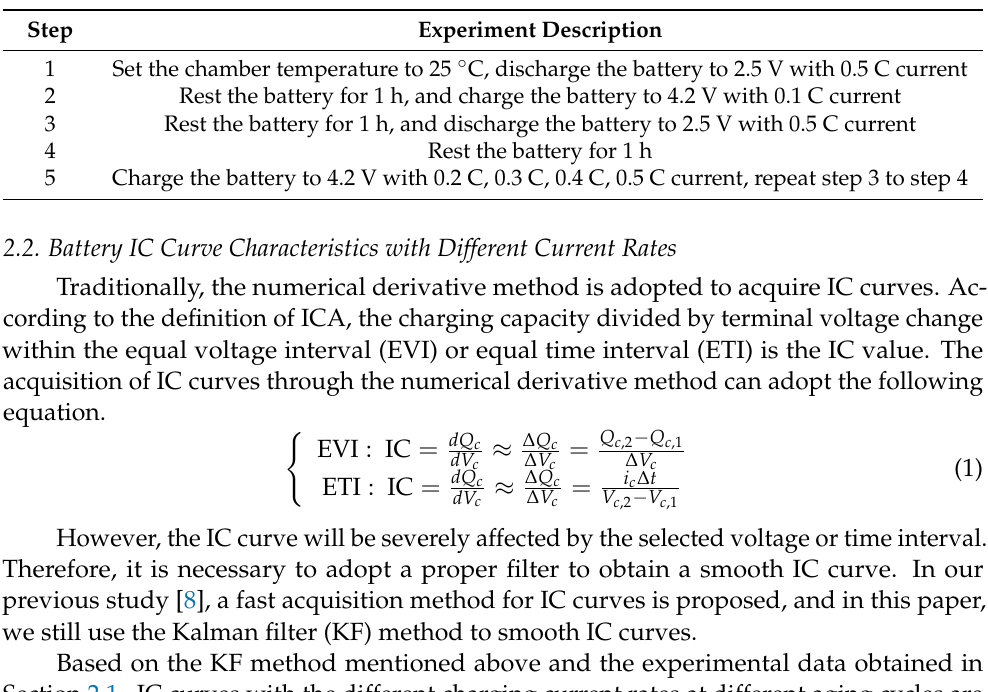
Table 1. Charging experiments at different charging current rates.